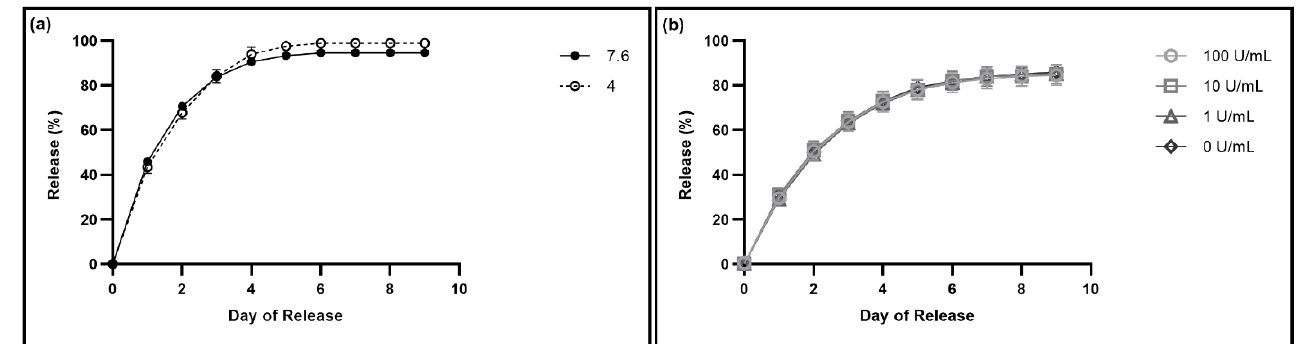
Figure 7. Impact of physiological factors on drug release from the thixogels. ( a ) Release of fluorescein into PBS with different pH values (7.6 and 4.0), with N = 3 for each release profile. Error bars hidden by plot symbols when not visible. A t -test was used to compare release into PBS with a pH of 7.6 versus 4.0 each day, indicating no statistically significant difference between the release profiles (Table S7). ( b ) Release of fluorescein into PBS with different concentrations of hyaluronidase (0, 1, 10, and 100 U/mL), with N = 6 for 100 U/mL and N = 3 for the other release profiles. Error bars hidden by plot symbols when not visible. A one-way ANOVA was used to compare release each day, indicating no statistically significant difference between the release profiles (Table S8).